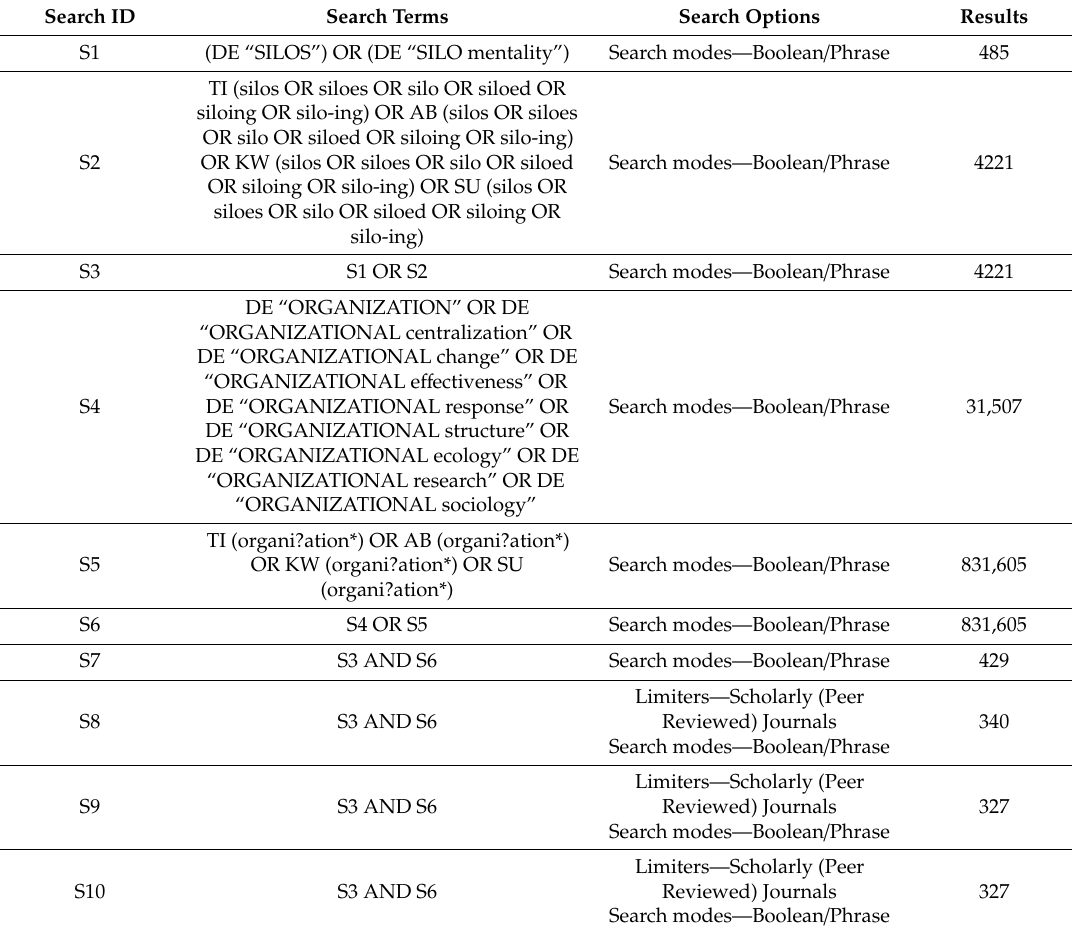
Table A1. Complete search strategy on Academic Search Ultimate (completed on 6 April